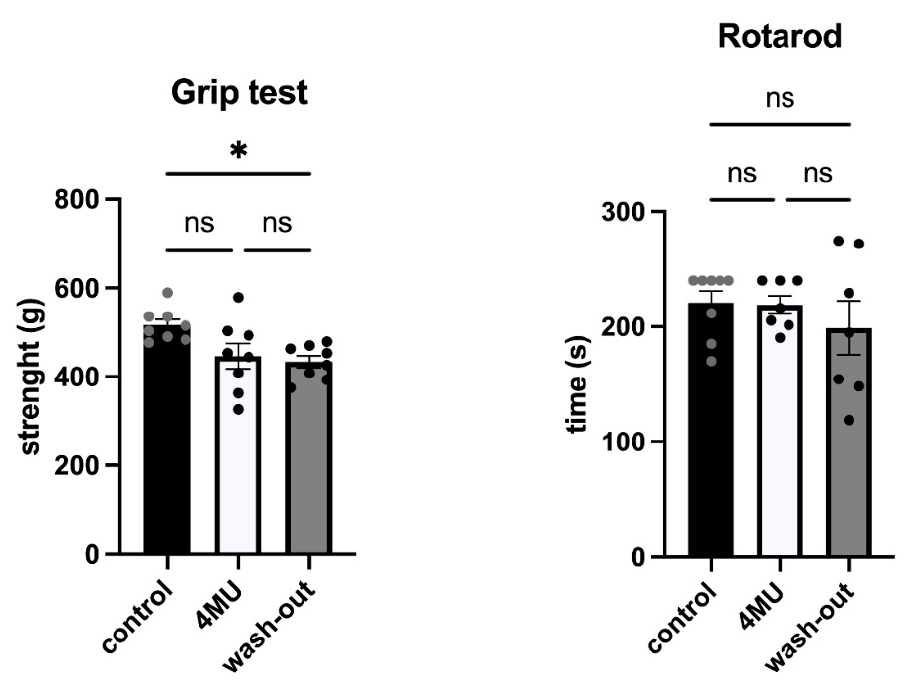
Figure 7. The results between placebo, 4MU-treated and wash-out groups did not show any changes in motor functions after 10 weeks of 4MU treatment, but significant difference was observed in the strength of the forelimbs between placebo and wash-out groups. Different color dots are used for easy identification of each data points. Data are expressed as mean ± SEM; * p < 0.05 by one-way ANOVA with Tukey’s multiple comparisons test. ns: no significance.